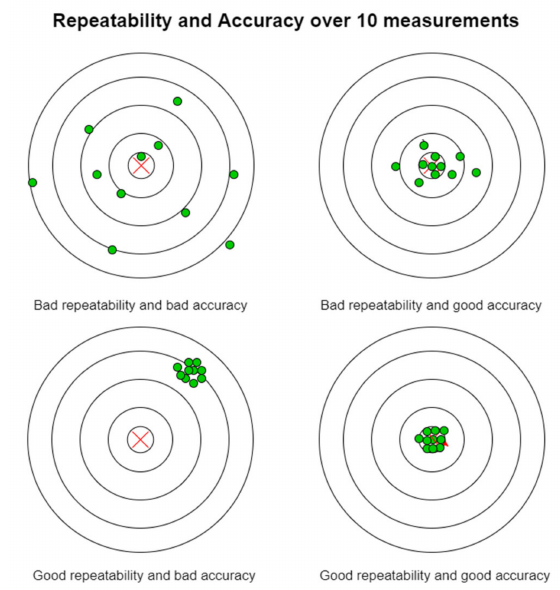
Figure 20. Repeatability and accuracy after 10 measurements. Adapted from